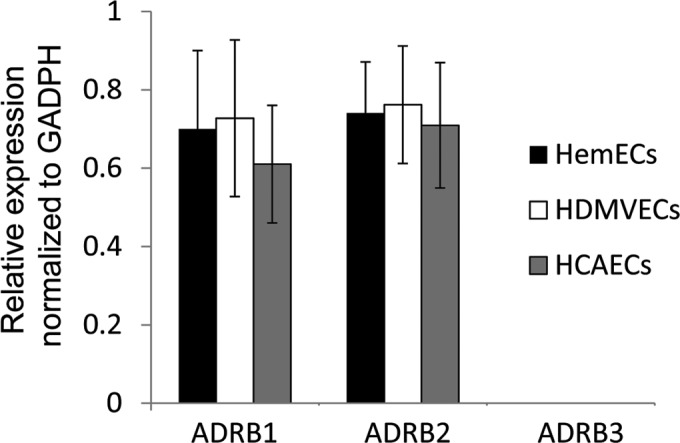
β-adrenergic receptor expression on infantile hemangioma (IH) and normal endothelial cells. RT-PCR expression assays measuring the steady state levels of ADRB1, ADRB2, and ADRB3 mRNA in primary cultures of human infantile hemangioma endothelial cells (HemECs), human dermal microvascular endothelial cells (HDMVECs) and human coronary artery endothelial cells (HCAECs). Expression data are represented as the relative abundance of each transcript normalized to the GAPDH levels.